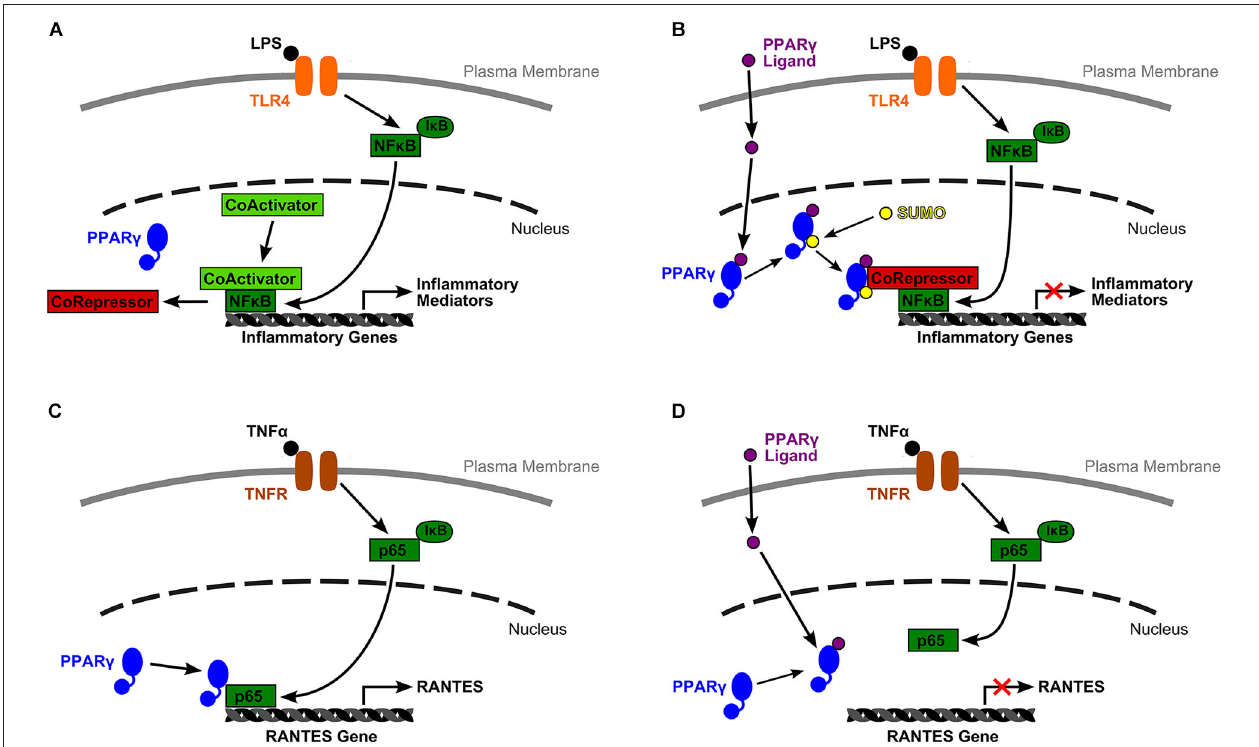
SUMOylation, which directs PPAR γ to the NCoR-HDAC3 corepressor complex. PPAR γ stabilizes this complex and prevents corepressor degradation, thus blocking gene transcription. (C) Wen et al. (2010) described a very different mechanism by which liganded and unliganded PPAR γ have opposing effects on RANTES gene transcription. In their model, downstream TNF α inflammatory signals relieve NF- κ B inhibition, phosphorylate the p65 subunit of NF- κ B, and induce its nuclear translocation. There, unliganded PPAR γ is required for successful association of p65 with the RANTES promoter. (D) However, ligand bound PPAR γ is incapable of associating with p65, probably due to a conformational change, and RANTES expression is